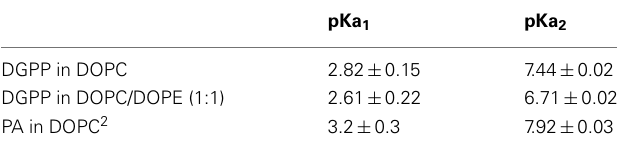
Table 1 | Ionization constants for 5mol% DGPP in multilamellar vesicles of DOPC and DOPC/DOPE; and for 10mol% PA in multilamellar vesicles of